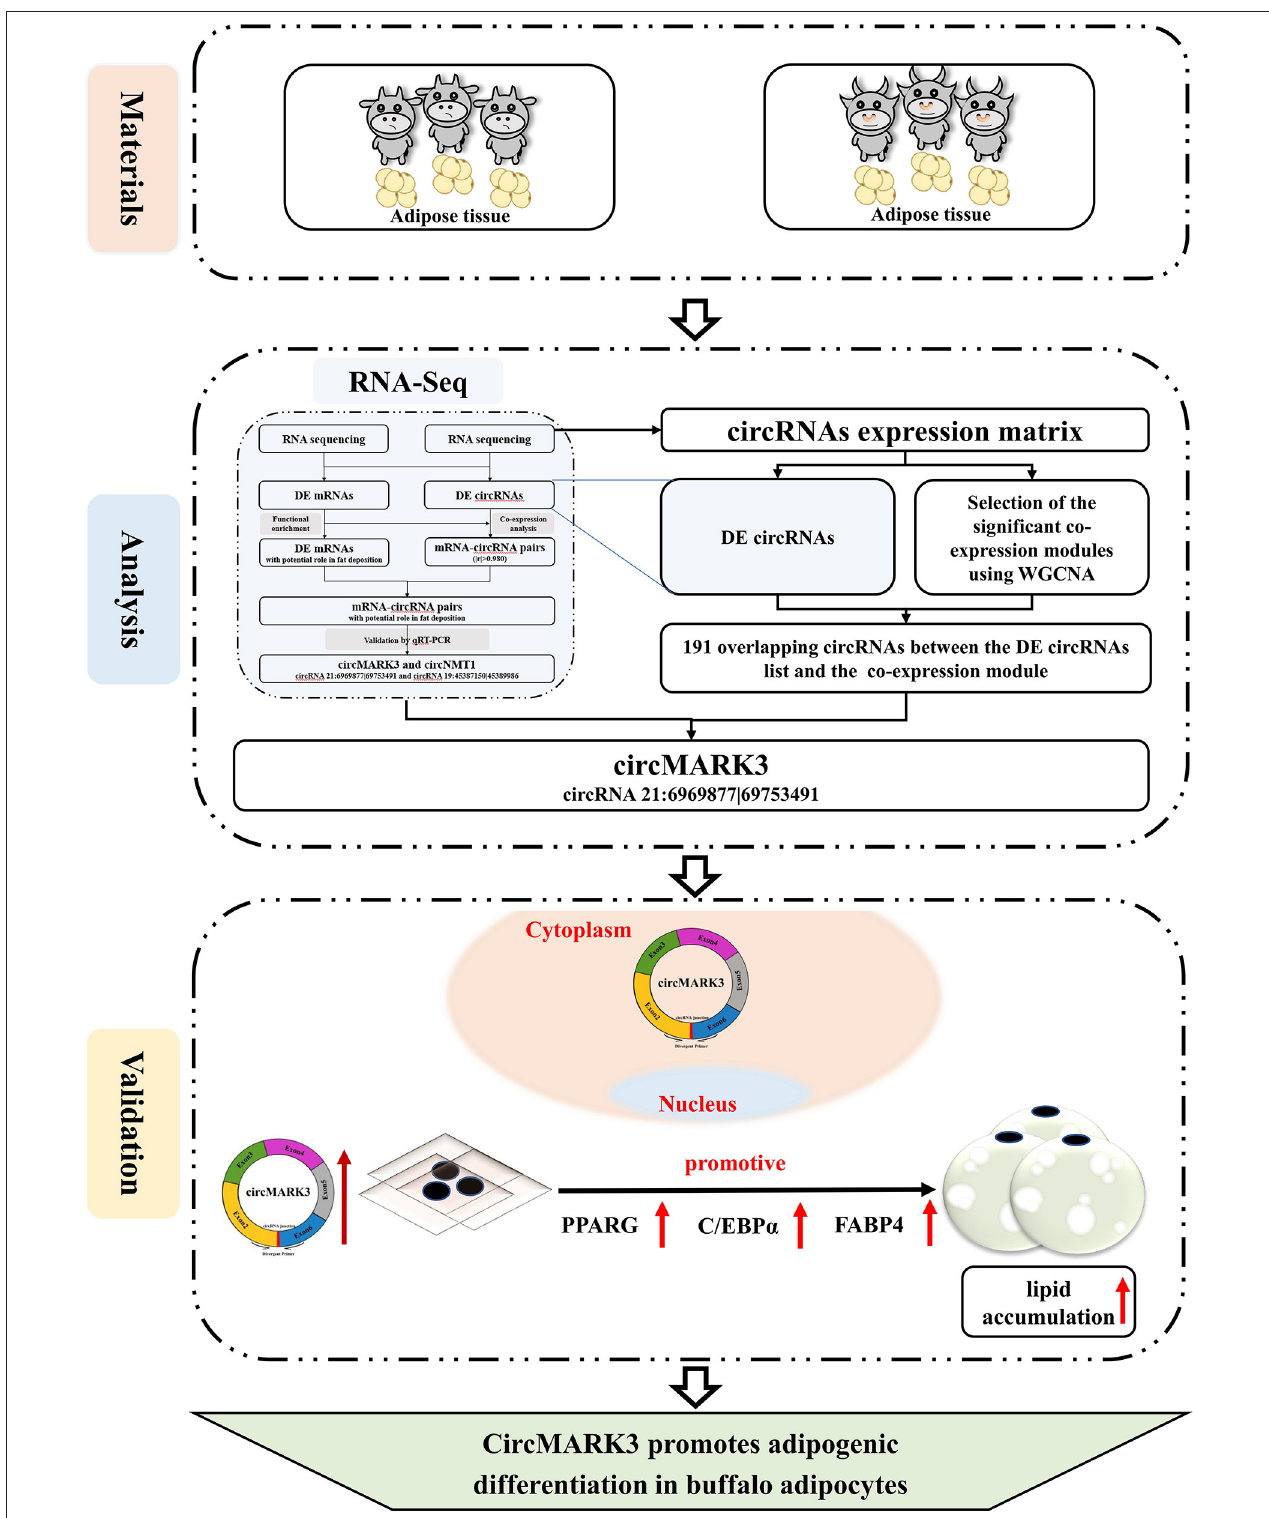
FIGURE 6 | Schematic illustration of the experimental procedure and main results. RNA-seq analysis is from a previous study (31).